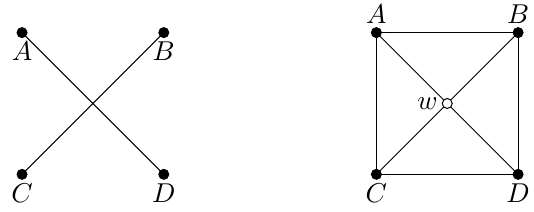
Figure 5 . 3-2 gadget: the three body interaction between A , B and C ( P A (cid:10) P B (cid:10) P C + P y is simulated by the interaction pattern shown in the (cid:12)gure.